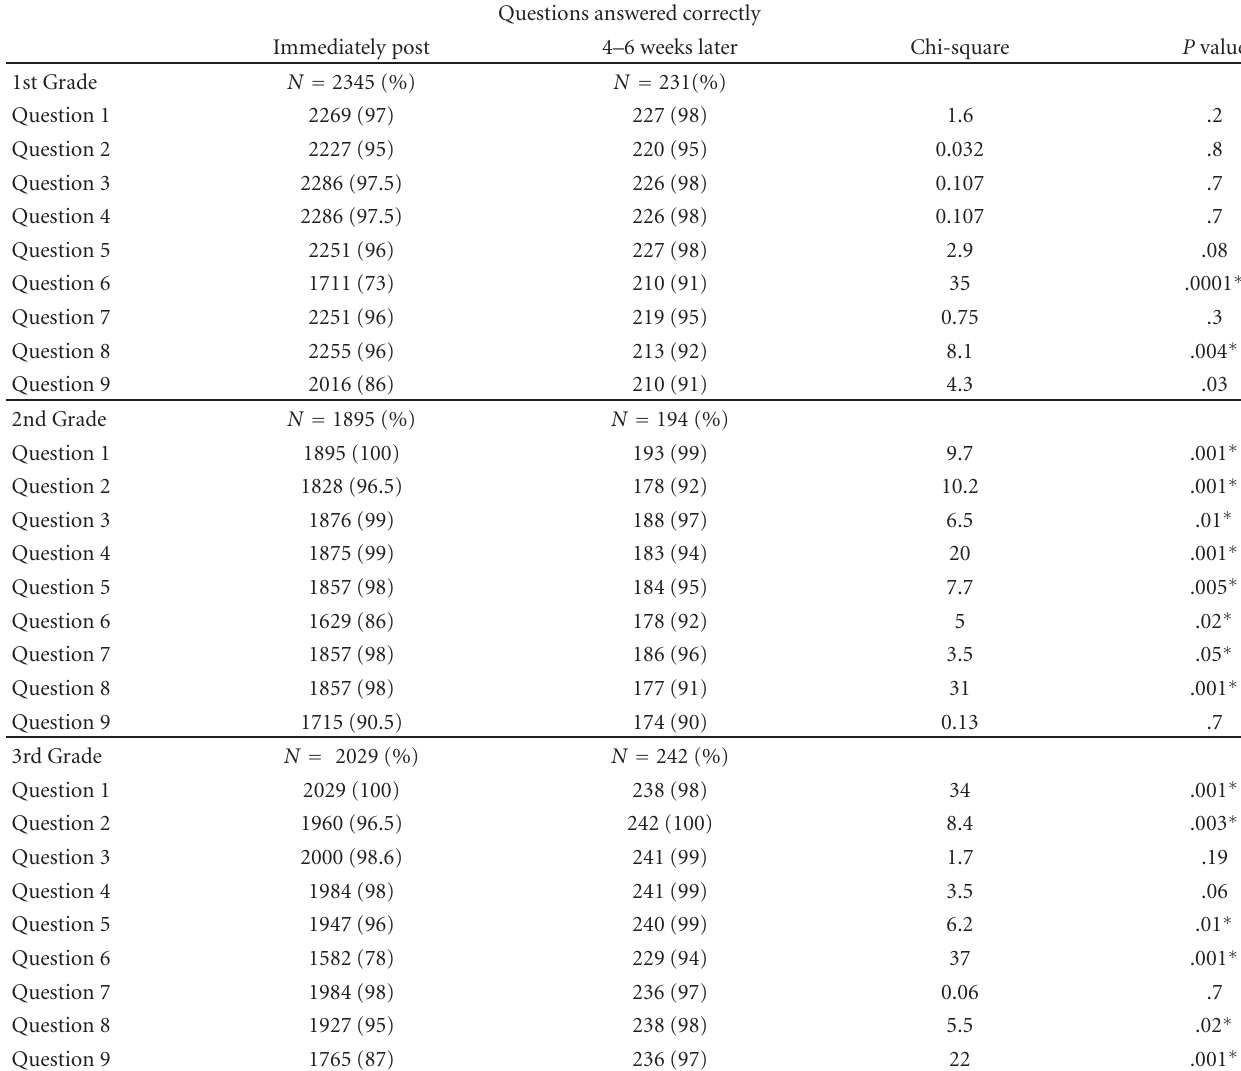
Table 3: Survey of children 4–6 weeks later using the same set of questions used immediately following the video (same schools).